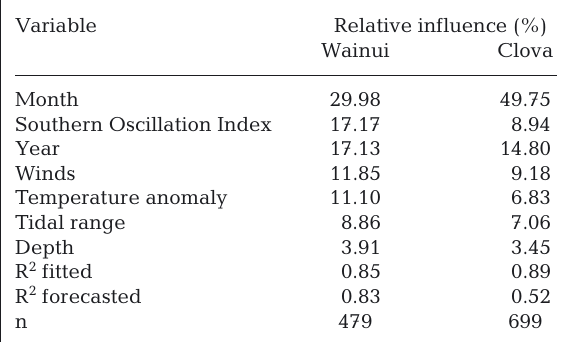
2. Relative influence (%) of predictor variables, R 2